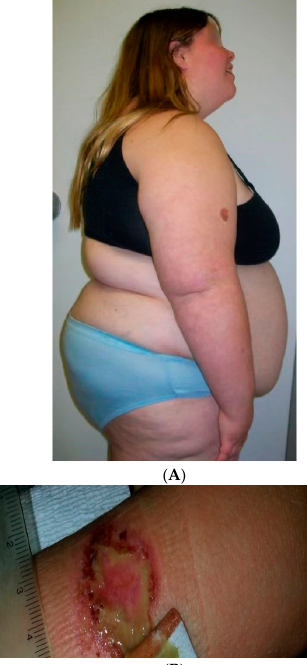
Figure 1. ( A ) A profile view from a 16-year-old female with Prader–Willi syndrome (PWS) showing central obesity as a major feature of this disorder. ( B ) A self-injury site noted in a separate patient with PWS, an abnormal clinical finding often seen in PWS.